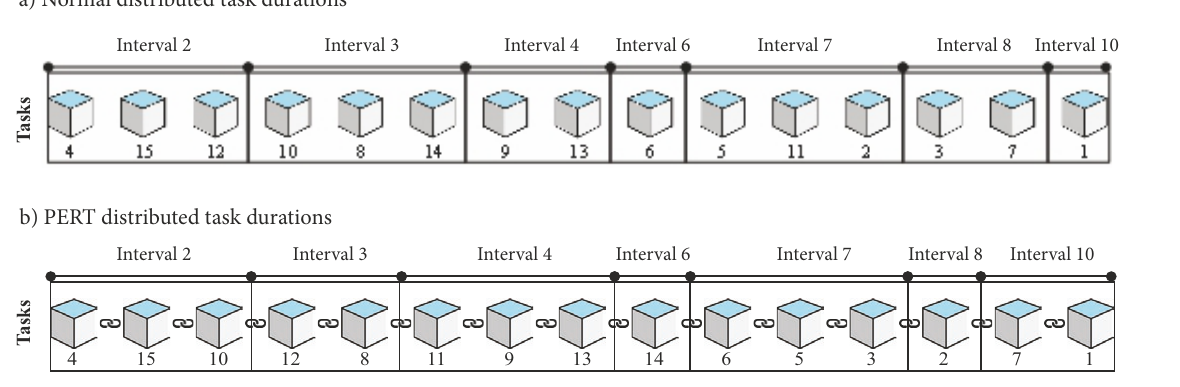
Figure 16. Optimal blocks sequence for project